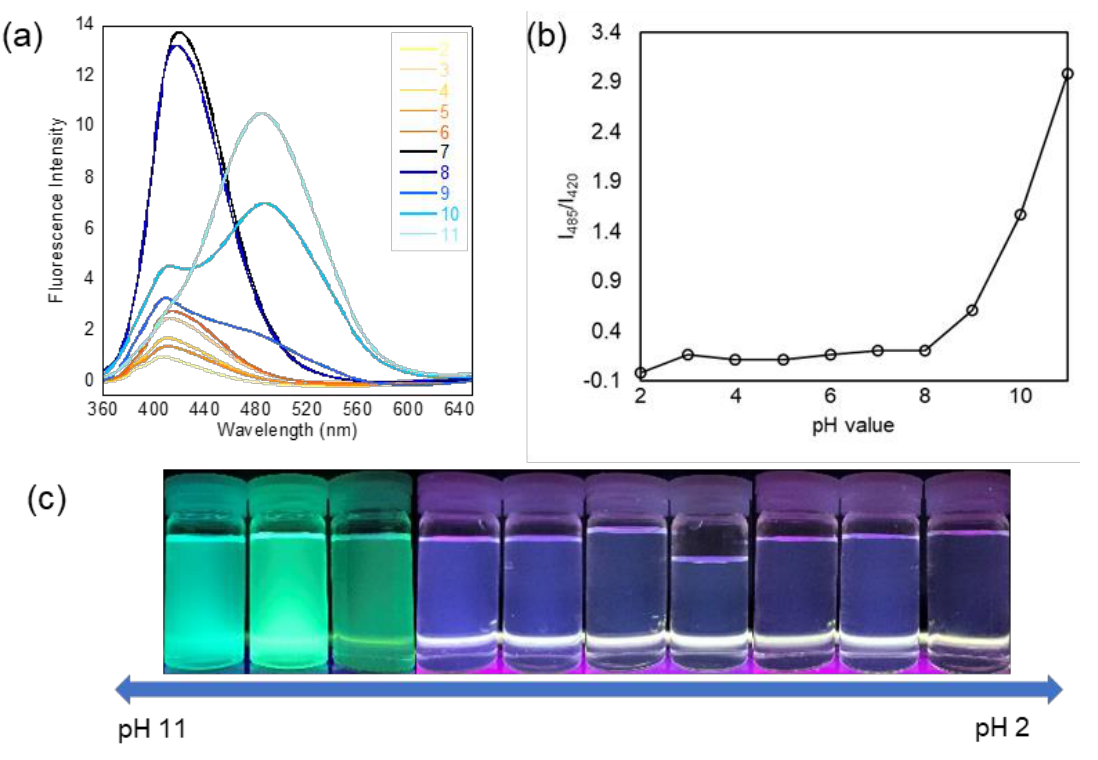
Figure 4. ( a ) Fluorescence spectra in H 2 O at different pH values (conc. = 0.1 mg/mL, λ abs = 340 nm), ( b ) I 485 /I 420 plots, and ( c ) photographs of NP(Fl) at different pH values after irradiation.